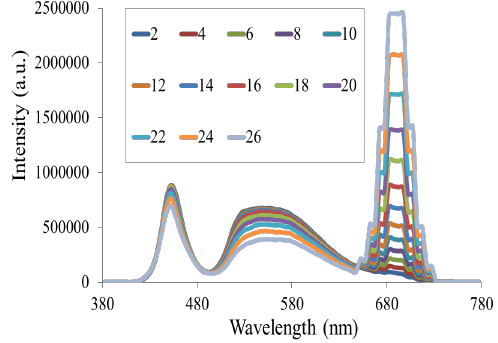
Fig. 3: The emission spectra of 5600 K WLEDs as a function of Mg 2 TiO 4 :Mn 4+ concentration.